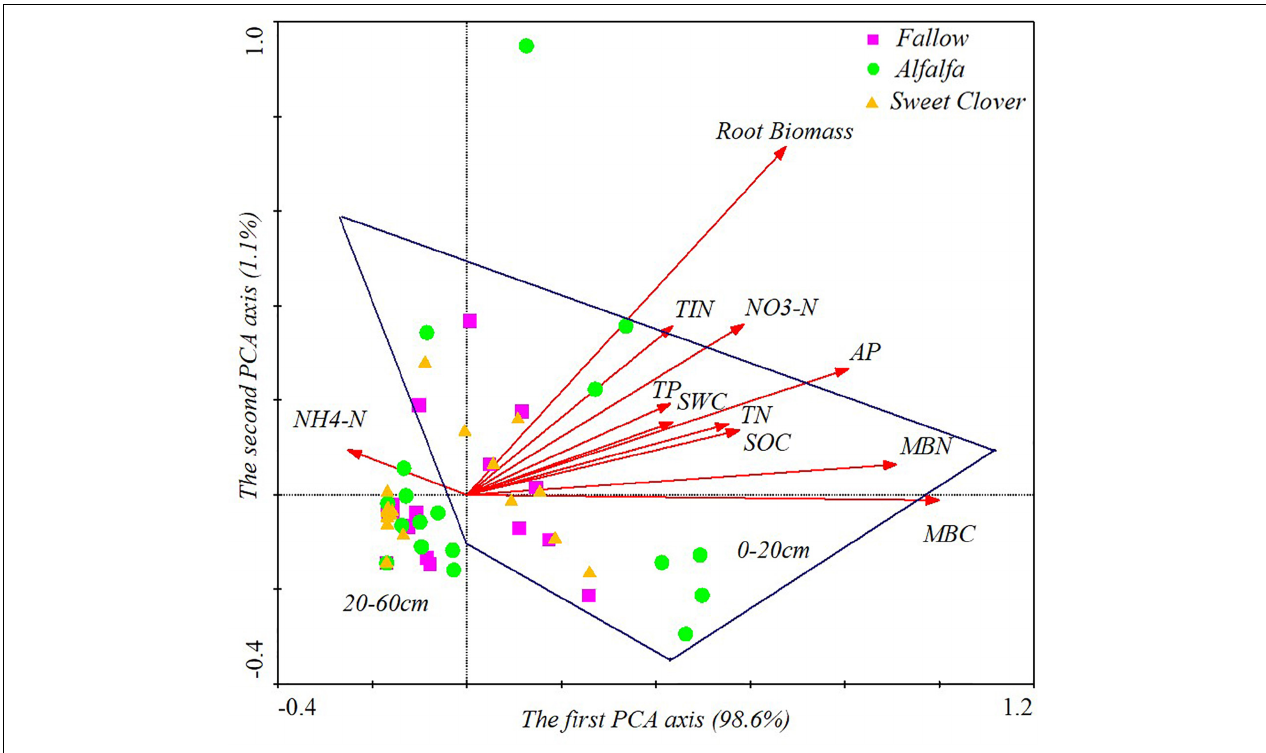
FIGURE 6 | Principal component analysis (PCA) results, showing the relationships for root biomass with soil properties in different soil layers (data were collected in 2019, 17 years after revegetation). NO 3 - -N, nitrate nitrogen; NH 4 + -N, ammonium nitrogen; TIN, total inorganic nitrogen; MBC, microbial biomass carbon; MBN, microbial biomass nitrogen; SOC, soil organic carbon; TN, total nitrogen; TP, total phosphorus; AP, available